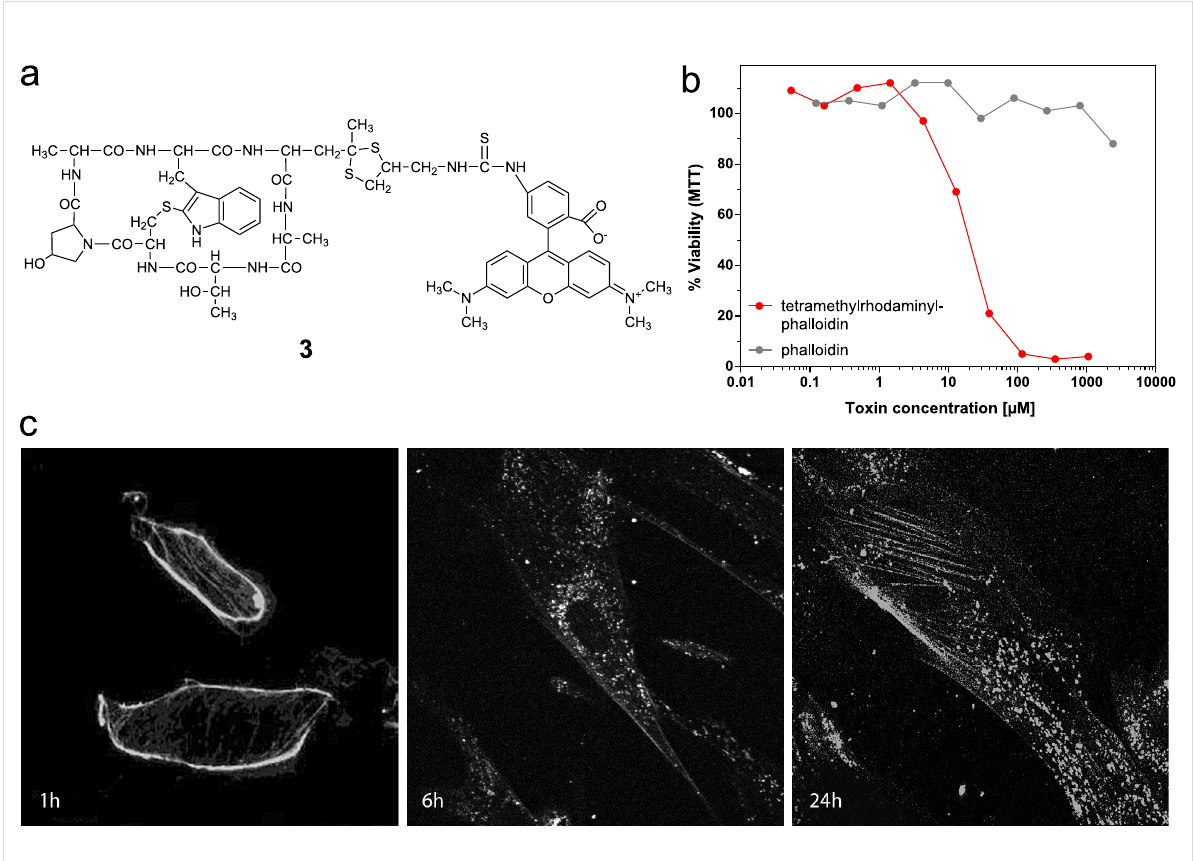
Figure 6: (a) Chemical structure of tetramethylrhodaminyl-phalloidin ( 3 ). (b) Growth inhibition of NIH 3T3 mouse fibroblasts by tetramethylrhodaminyl- phalloidin ( 3 ) versus phalloidin ( 1 ) after 72 h incubation time. (c) Binding and uptake of tetramethylrhodaminyl-phalloidin ( 3 ) in NIH 3T3 mouse fibro- blasts after 1, 6 and 24 h, as documented by fluorescence microscopy.